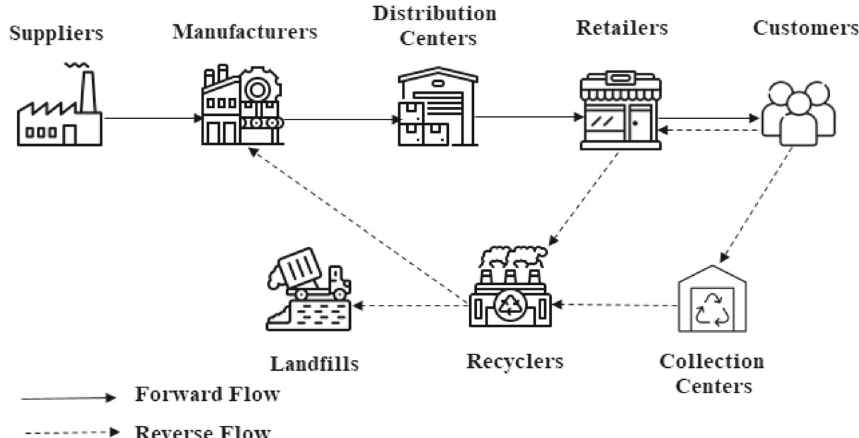
Fig. 2 A closed-loop supply chain network for